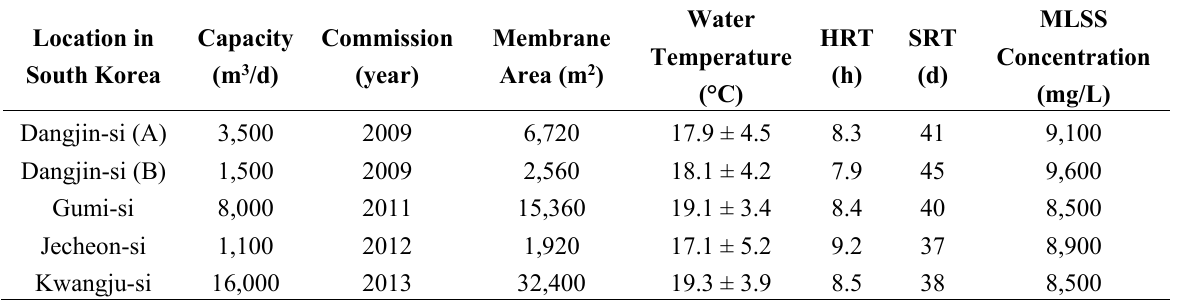
Table 1. Key information of the DMBR TM systems treating municipal wastewater larger than 1000 m 3 /d.